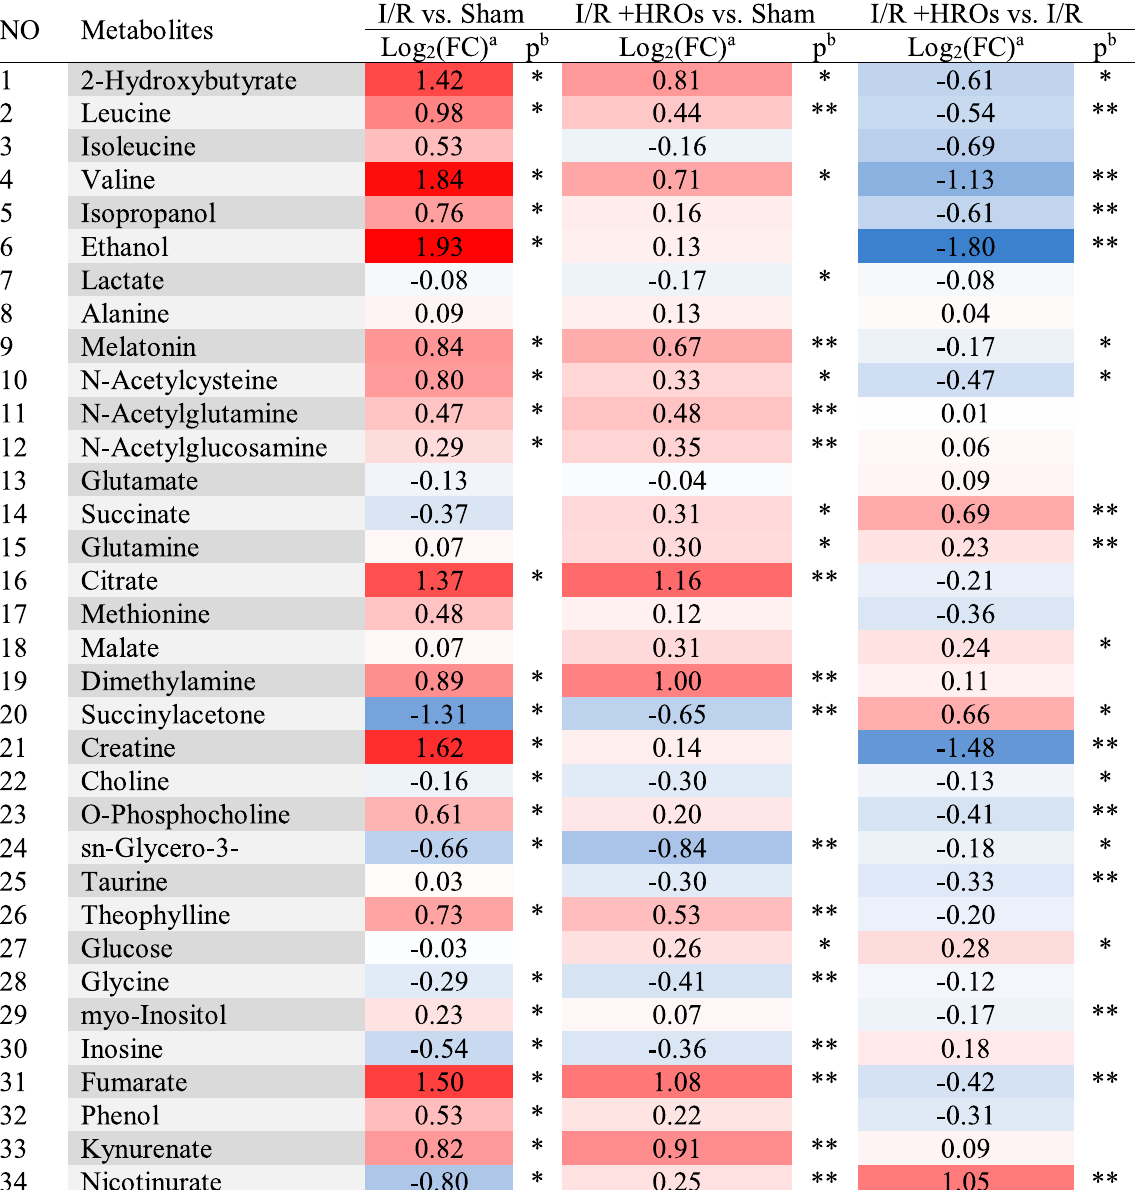
TABLE 2 | Identi fi ed metabolites in kidneys and their fold-change values and associated p values.